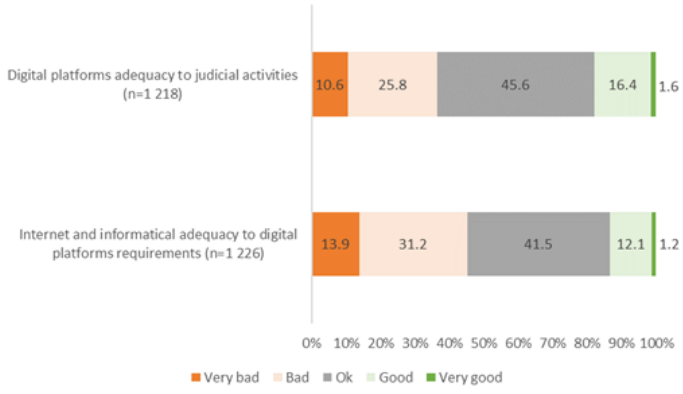
Figure 4: Equipment and Digital Platforms Adequacy